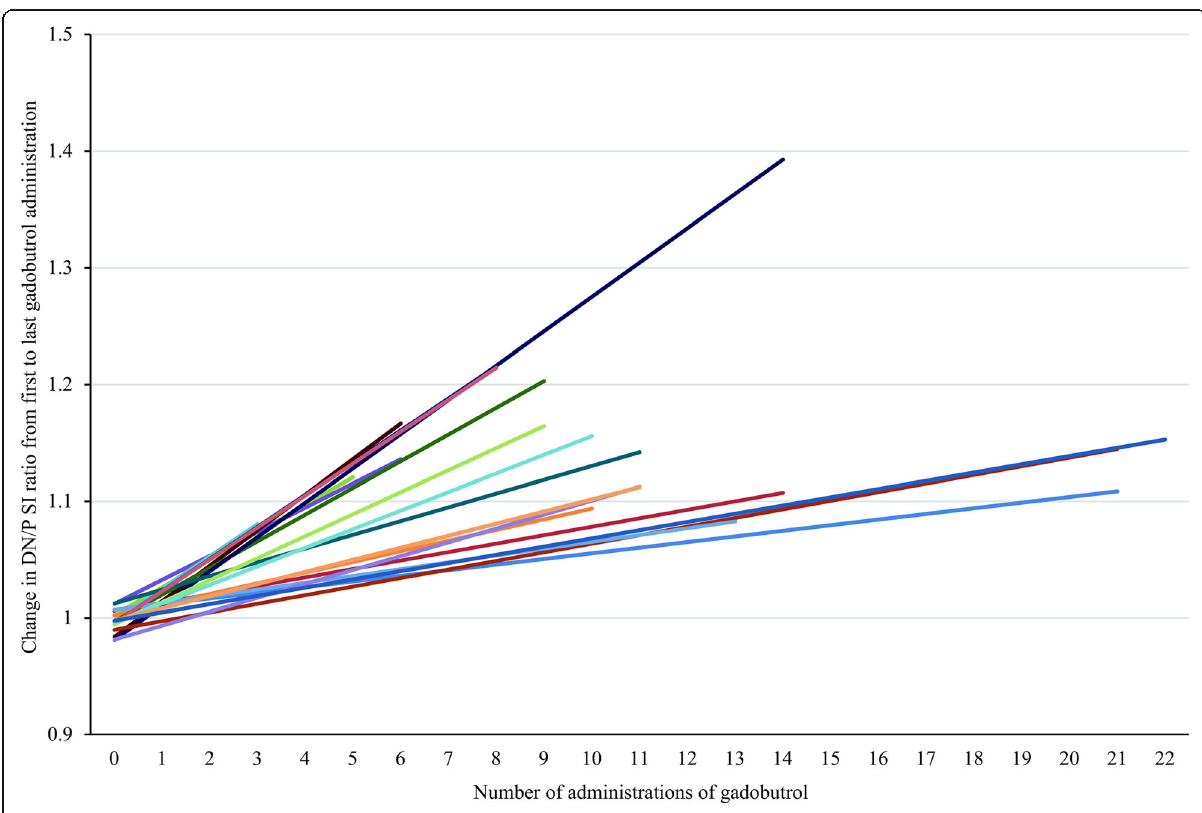
Fig. 4 First and last DN/P SI ratios for patients with visible T1-signal changes after two or more administrations of